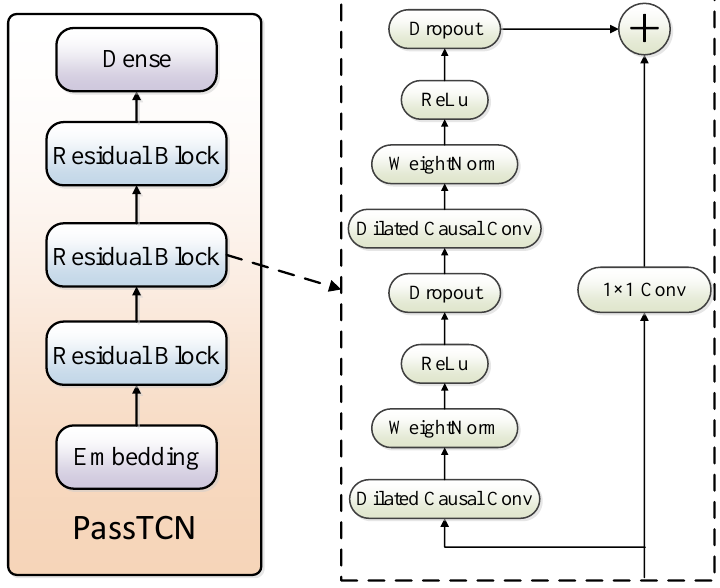
Figure 2. Password-guessing model based on